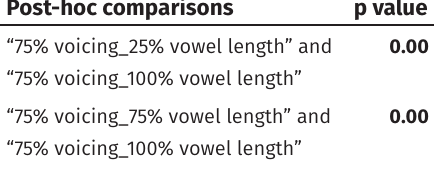
Table 8: Post-hoc Bonferroni test results (significant results only) among the test conditions that presented 75% of